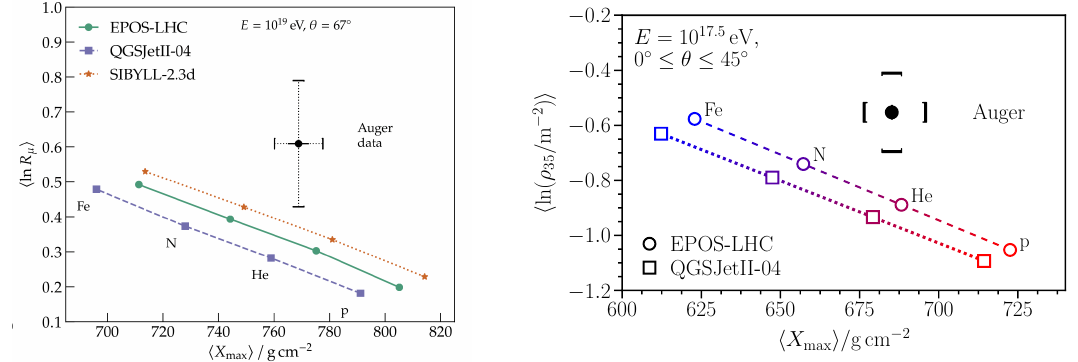
Figure 2: Left: Auger SD measurement and model predictions of the average muon number and the depth of shower maximum for the events in the energy bin corre- sponding to 10 19 eV from Figure 1 (right). [ 8 ] Right: Auger UMD measurement and model predictions of the average muon number and the depth of shower